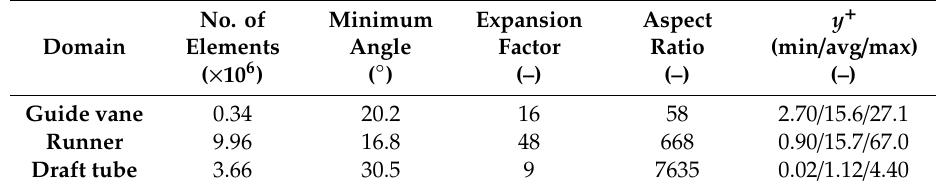
Table 2. Quality parameters of the mesh used in the transient simulations.